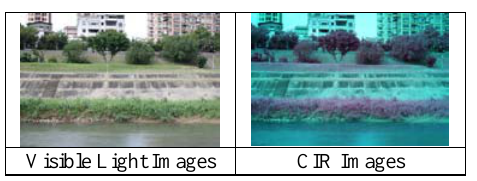
Figure 3. Image categories for point cloud generation